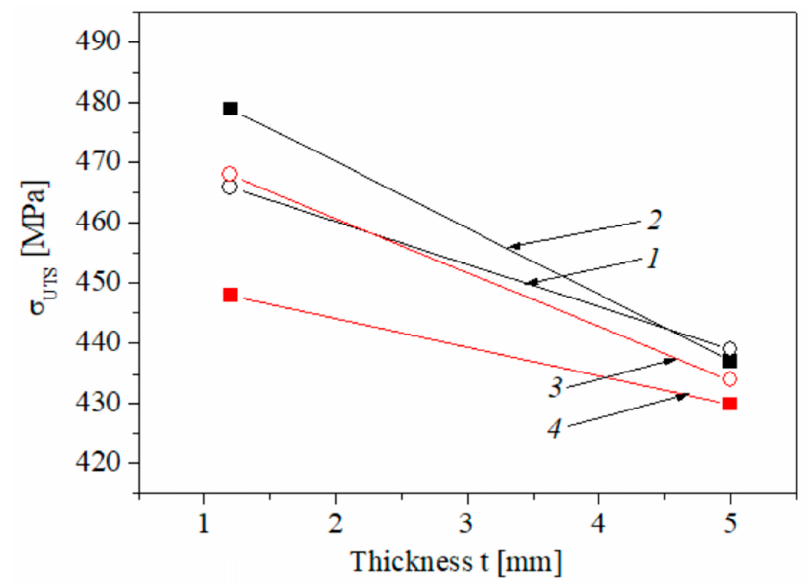
Figure 7. The average strength of steel A ( 1 , 2 ) and B ( 3 , 4 ) determined using specimens of transverse ( 1 , 3 ) and longitudinal ( 2 , 4 ) orientation.